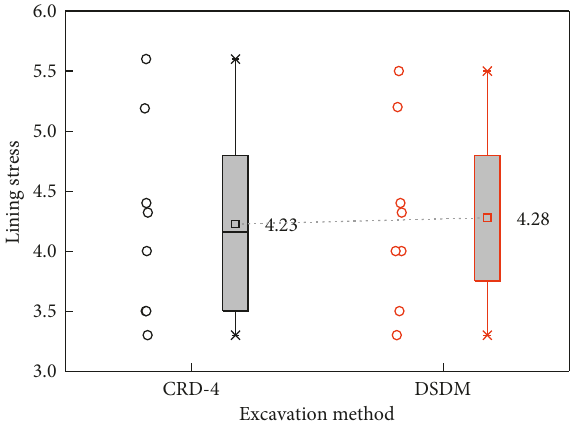
Figure 14: Ultimate lining stress at different points (working conditions 3 and 6).